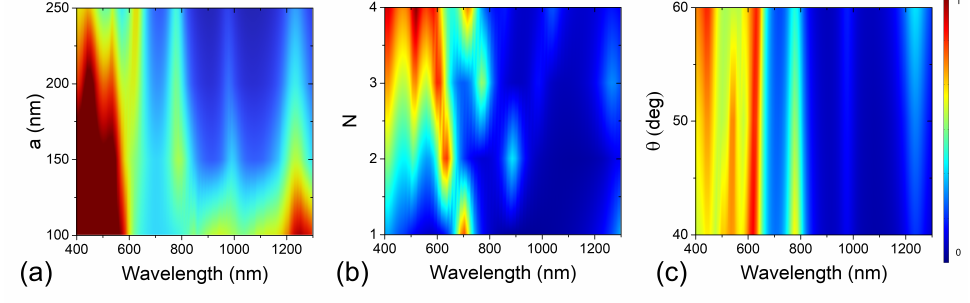
Figure 2. Normalized absorbance map of the plasmonic metasurface as a function of ( a ) the in-plane periodicity a in the range 100–250 nm and ( b ) the out-of-plane periodicity N in the range 1–4. ( c ) The angle of incidence in the range 40–60 ◦